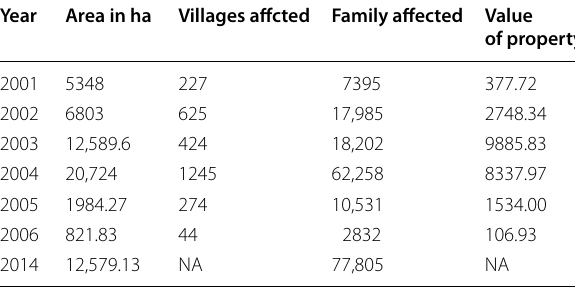
Table 2 Year wise area Eroded and Affected